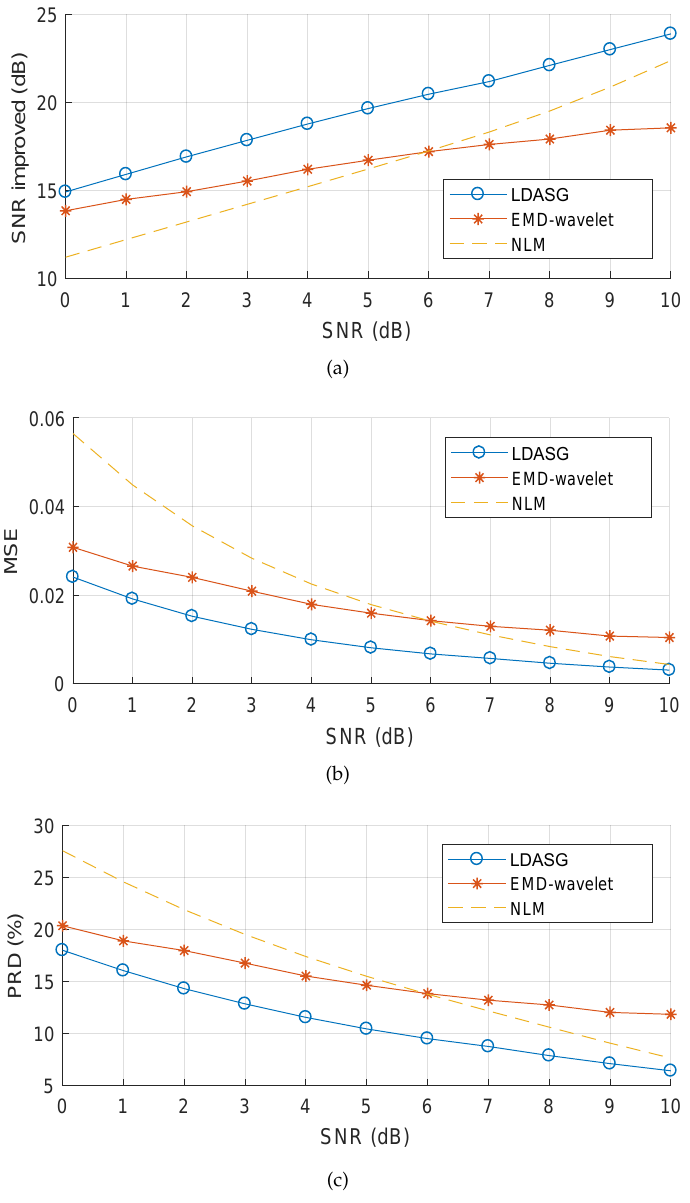
Figure 7. Average ECG denoising performance of the three methods on different noisy ECG signals with the SNR level from 0 dB to 10 dB. ( a ) SNR improvement; ( b ) MSE; ( c )